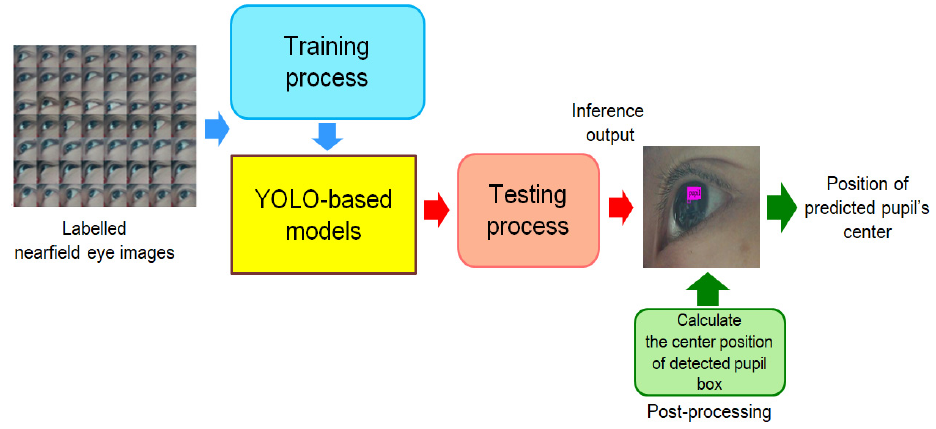
Figure 10. The training and testing processes by the YOLO-based models for tracking pupil.